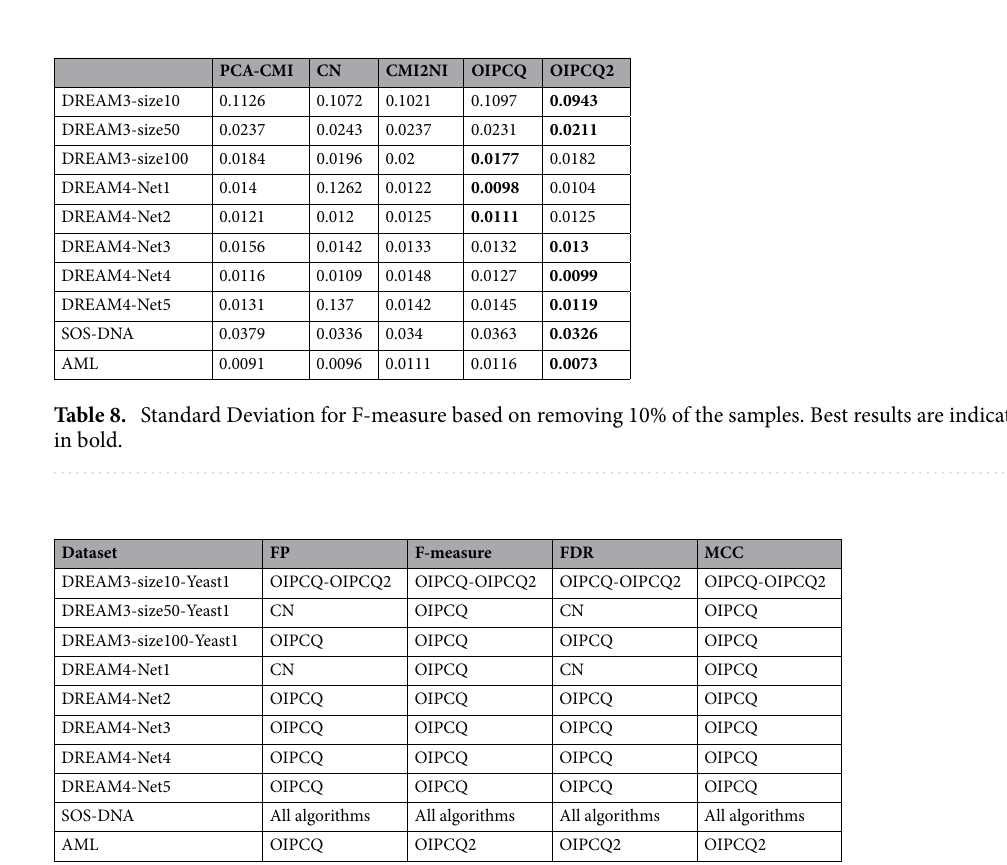
Table 9. Report Best algorithm for each data